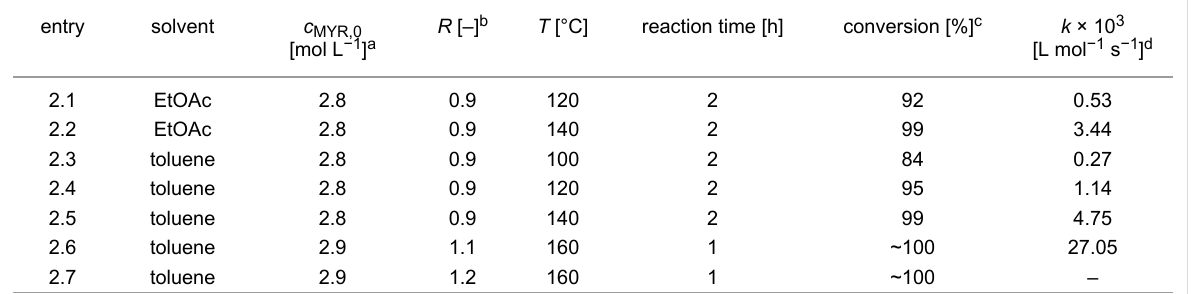
Table 2: Solvents, reaction conditions, conversions and reaction rate constants, k , for small scale batch reactions of myrcene ( 1 ) with acrylic acid ( 2b ); for further details on derivation of k values see Supporting Information File 1.